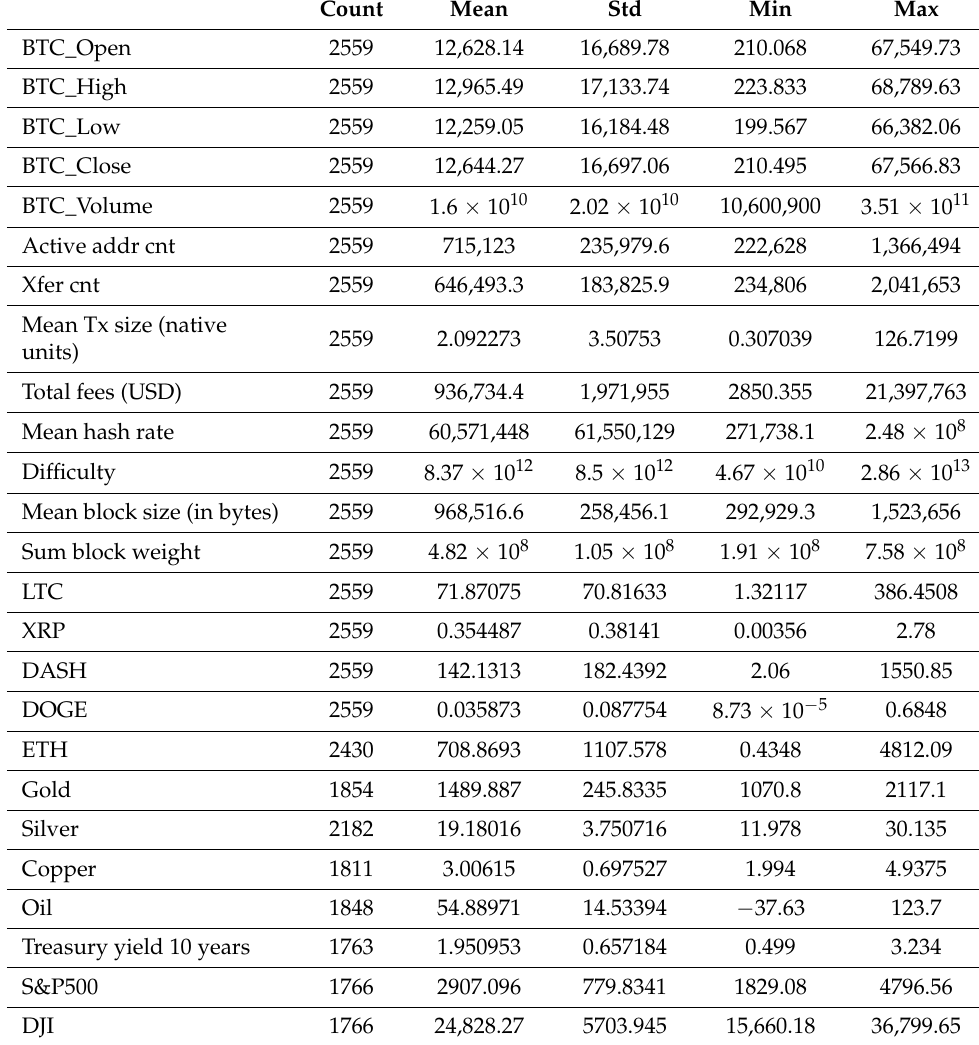
Table 2. Statistical features of explanatory